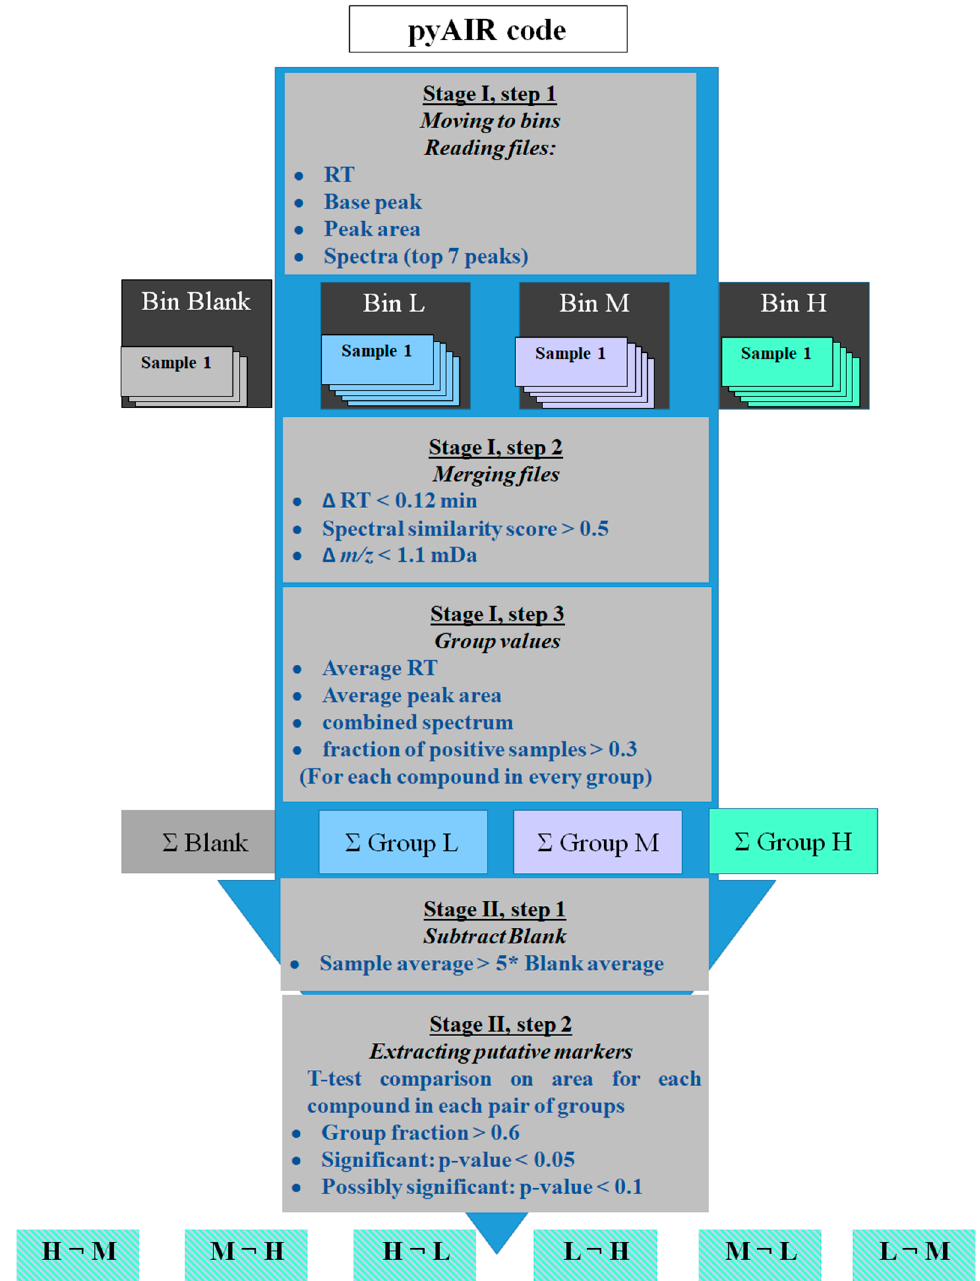
Figure 5. pyAIR algorithm description; after peak detection and deconvolution by MS-DIAL, pyAIR is moving to bins, grouping, performing blank subtraction, groups comparison, and statistics until finding putative biomarkers. The algorithm is suitable for a large number of groups that can be individually processed, and then compared to each other.